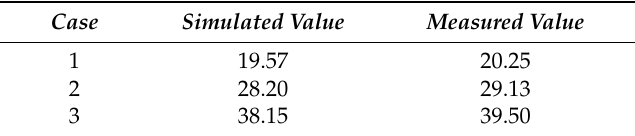
Figure 8. Validation of the circuit model through conducted emission test: ( a ) time-domain simulated and measured current waveforms; and ( b ) the frequency spectrum of the voltage noise. Table 6. Rms values (in mA) of the simulated and measured currents at the package pins.